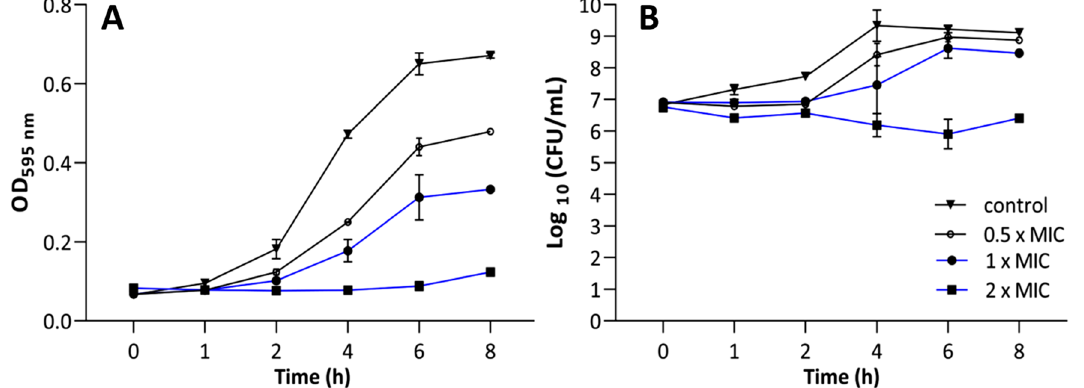
Figure 3. Time-kill assay of compound 10d for S. aureus ATCC 25923 during an 8-h incubation period represented by the bacterial growth curve ( A ) and number of CFUs ( B ). Data represent the mean of two biological repetitions with two technical replicates each ±